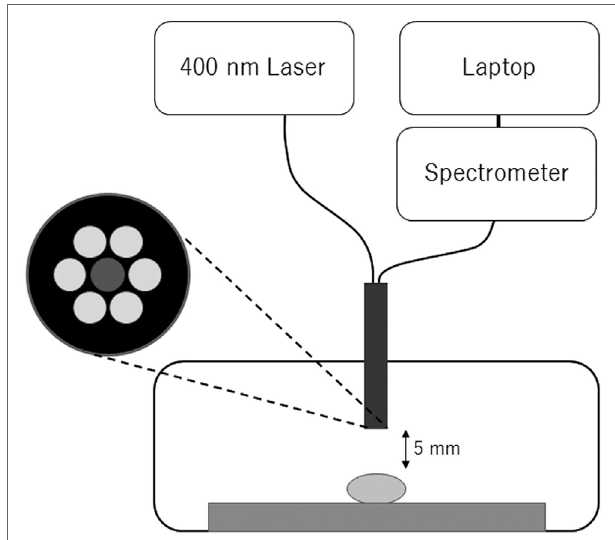
FigUre 1 | Configuration of the fluorescence detection system. A semiconductor laser unit with a wavelength of 400 nm was used as the excitation light source. A compact spectrometer and laptop were used for the fluorescence measurement. These components were connected to a custom-made probe consisting of an optical fiber bundle (each 0.4 mm in diameter). The fiber at the center was used to collect the fluorescence from the sample, and the others were used to deliver the excitation light. The tumor sample was placed on a glass slide in a 3D-printed box, where the distance between the tumor sample and probe was fixed in a dark environment. The measurement was performed during